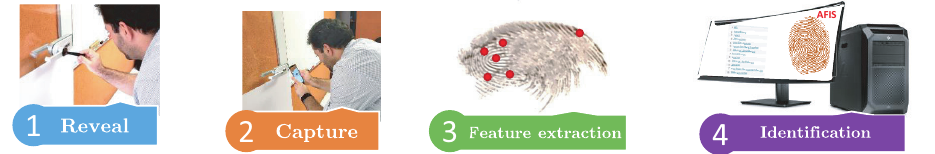
Figure 4. Four stages before and during the fingerprint identification where the human errors could produce